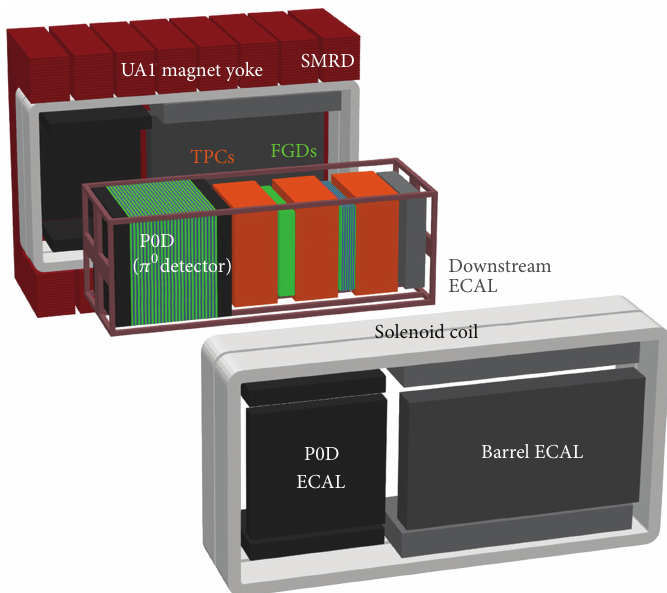
Figure 10: An exploded view of the ND280 off-axis near detector for the T2K experiment. The ND280 is a magnetized tracking detector comprising of several subdetectors located inside the UA1 magnet (see the main body of text for detailed descriptions). Figure from